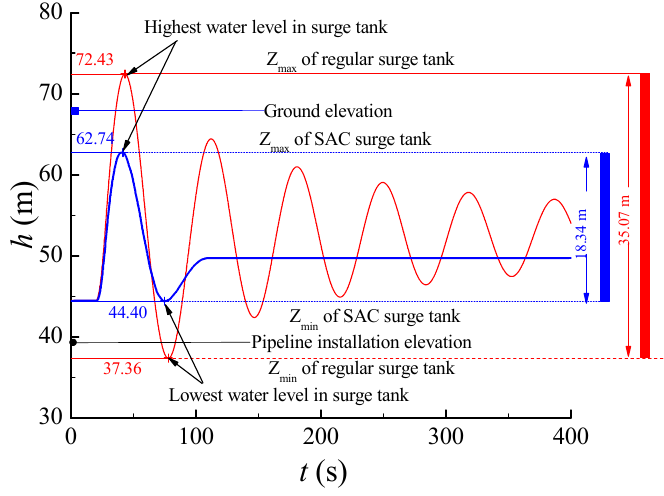
Figure 14. Comparison of the water level fluctuation of the surge tanks.